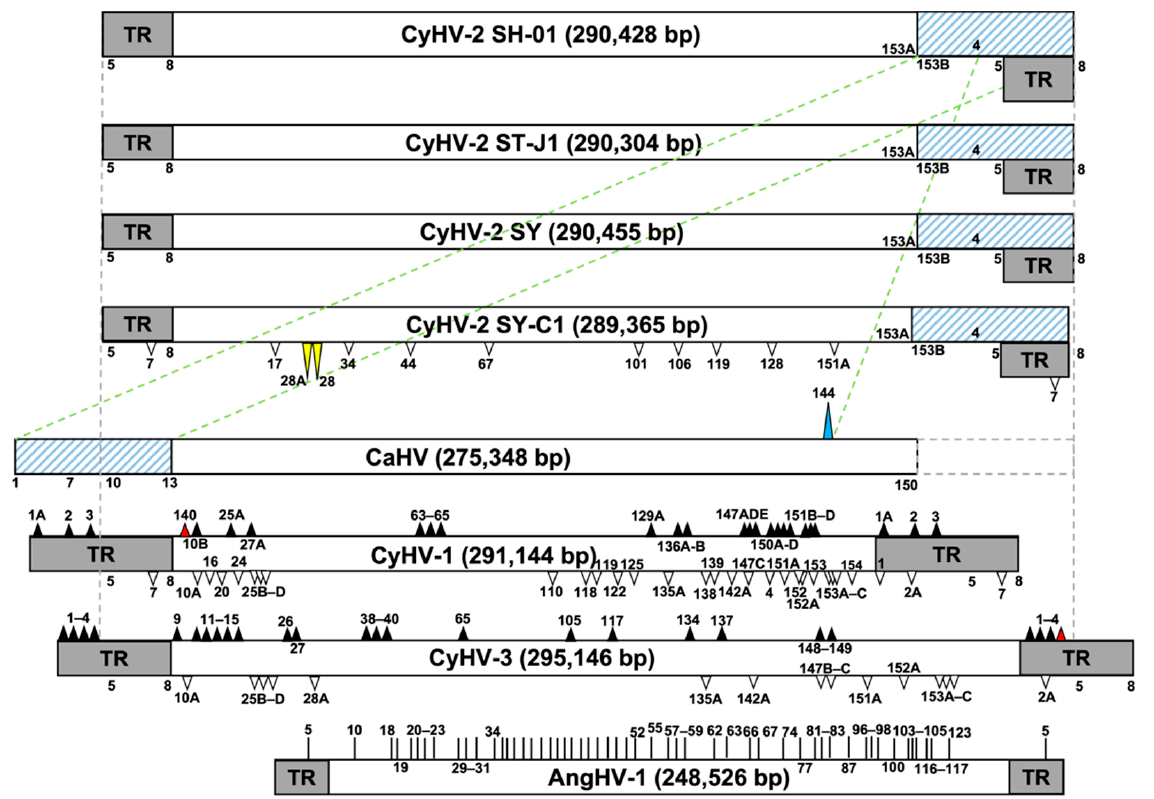
Figure 2. Comparison of genome structures between SH-01 and the other seven strains. Long frames and grey frames indicate the sizes of genomes and terminal repeat (TR) regions, respectively. Long yellow triangles show that the positions of ORF28 and ORF28A in SY-C1 are opposite to each other relative to SH-01 and other isolates of CyHV-2. White triangles in SY-C1, CyHV-1, and CyHV-3 indicate deletions relative to SH-01. Black triangles in CyHV-1 and CyHV-3 indicate insertions relative to SH-01. ORF140, with a large translocation in CyHV-1, and ORF4, located at the TR in CyHV-3, distinct from SH-01, are marked as red triangles. The dashed frame at the upstream end of the CaHV genome indicates the nucleotides deleted relative to SH-01. The long, green, diagonal dashed lines between SH-01 and CaHV indicate that the 5 ′ -terminal ORF1 − 13 of CaHV (blue shaded frame) corresponds to the 3 ′ -terminal ORF153B − ORF8 ( ORF144, with long blue triangles at the downstream end, of CaHV corresponds to ORF4 of SH-01) of SH-01 (blue shaded frame), similar to ST-J1, SY, and SY-C1 (absence of ORF7 ) marked in blue-shaded frames. The short vertical lines in AngHV-1 indicate the ORFs homologous to SH-01.